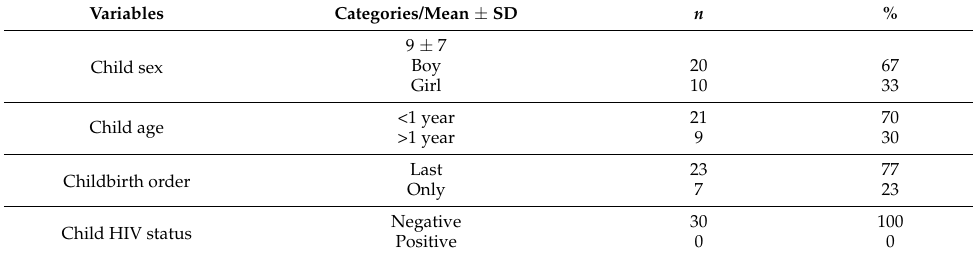
Table 2. Characteristics of